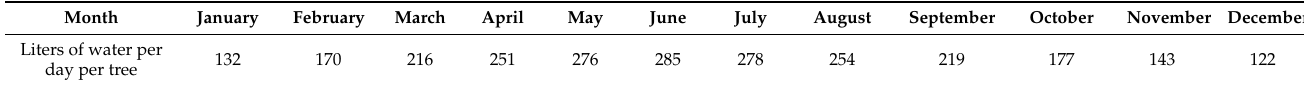
Table 6. Irrigation scheduling during the two growing seasons, 2016 and